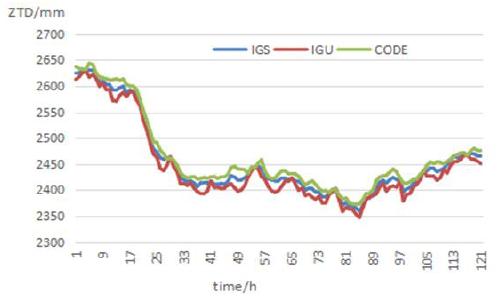
Figure 2. ZTD alignment diagram